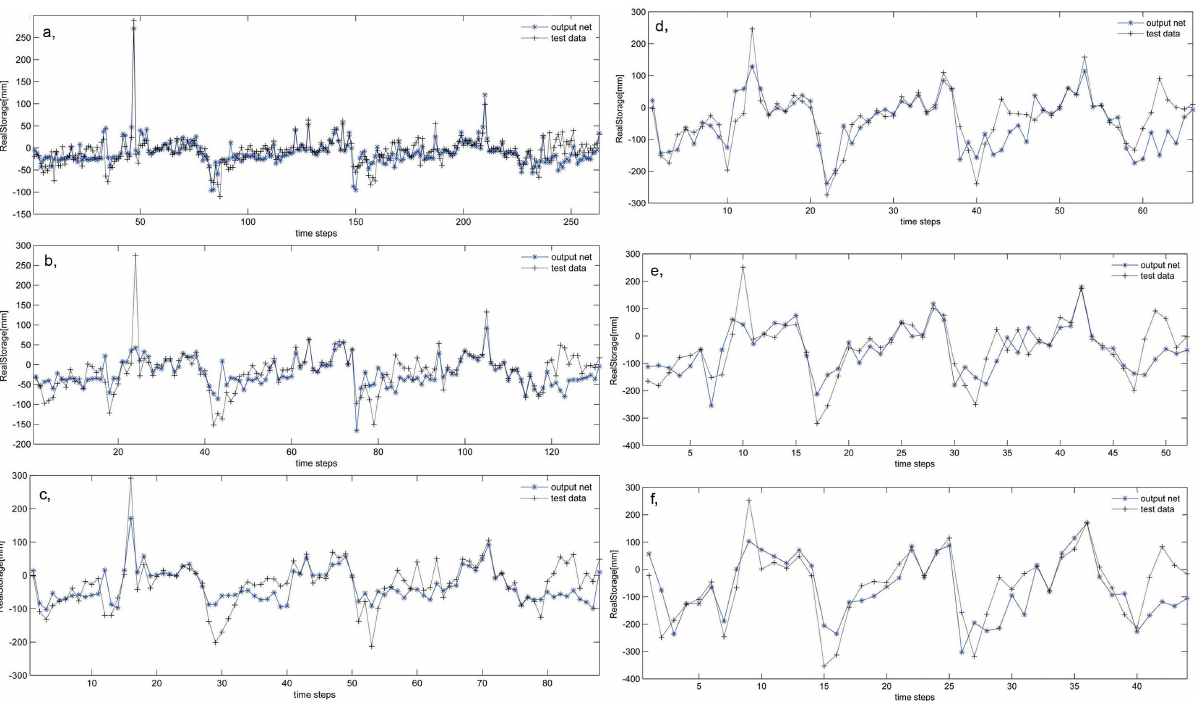
Fig. 13. Comparison of observed water storage (test data) and observed water storage simulated by the ANN (output net) in monthly sums. Test period of the neural net in subbasin K¨onigsseetal – (a) =5-day, (b) =10-day, (c) =15-day, (d) =20-day, (e) =25-day, (f) =30-day